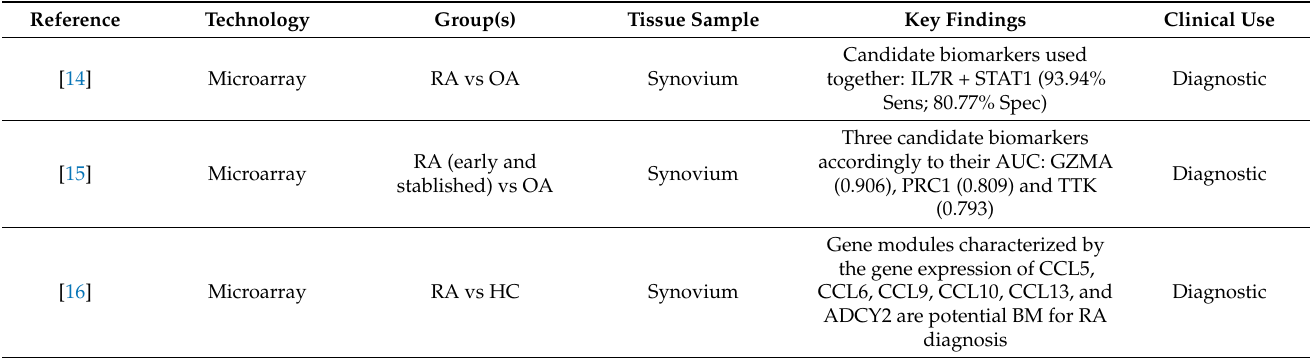
Table 1. Example of studies using transcriptomics to obtain candidate biomarkers with potential clinical use in